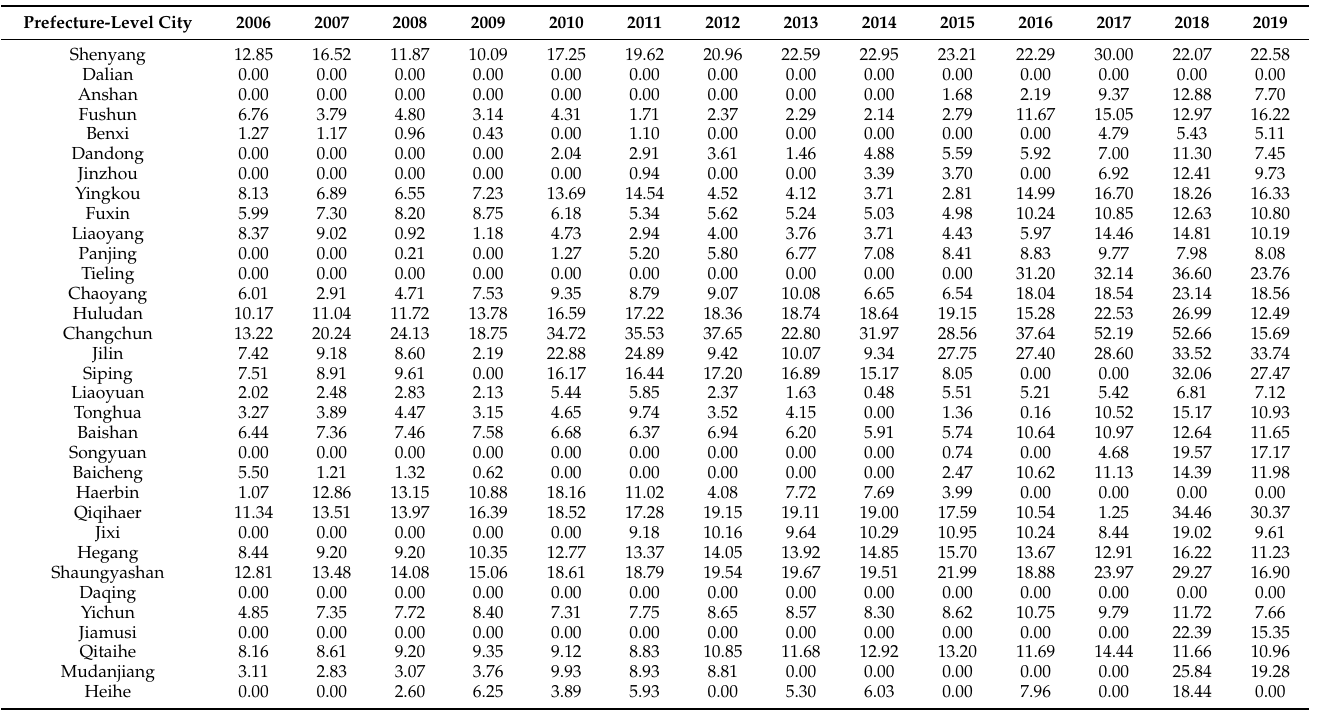
Table A2. Potential CO 2 emission reduction (PCR) in northeast China during the 2006–2019 period (million